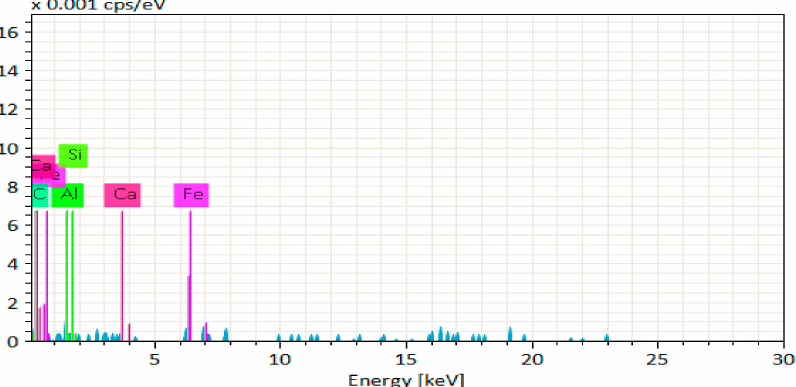
Figure 20. EDS graph of GPC-A0F mix